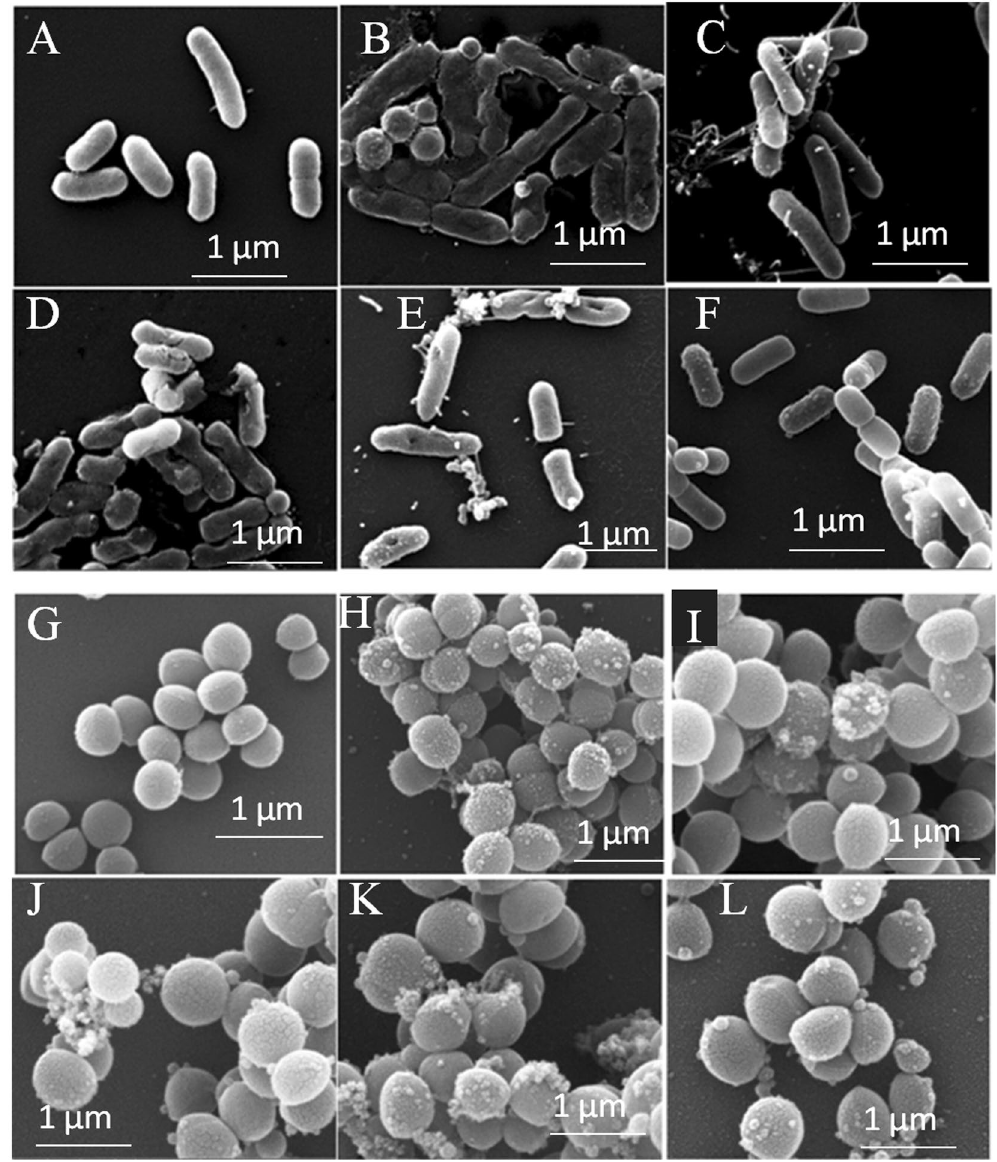
Figure 4. Electron microscopic visualization of the effect of Chrysophsin-1 and its analogs on E. coli ATCC 25922 and S. aureus 25923 at peptide concentrations of 2 X MIC. SEM micrographs of E. coli : ( A ) Control, no peptides; ( B ) Melittin-treated, positive Control; ( C ) Chr-1-treated. ( D ) G8P-Chr-1-treated ( E ) G13P-Chr-1 treated ( F ) G18P-Chr-1 treated SEM micrographs of S. aureus : ( G ) Control, no peptides; ( H ) Melittin-treated, positive Control; ( I ) Chr-1-treated. ( J ) G8P-Chr-1-treated ( K ) G13P-Chr-1 treated ( L ) G18P-Chr-1